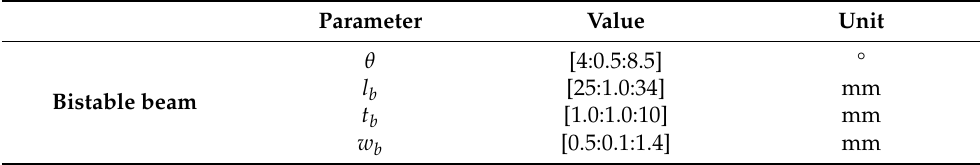
Table 2. Analysis of structural parameters of bistable beams.